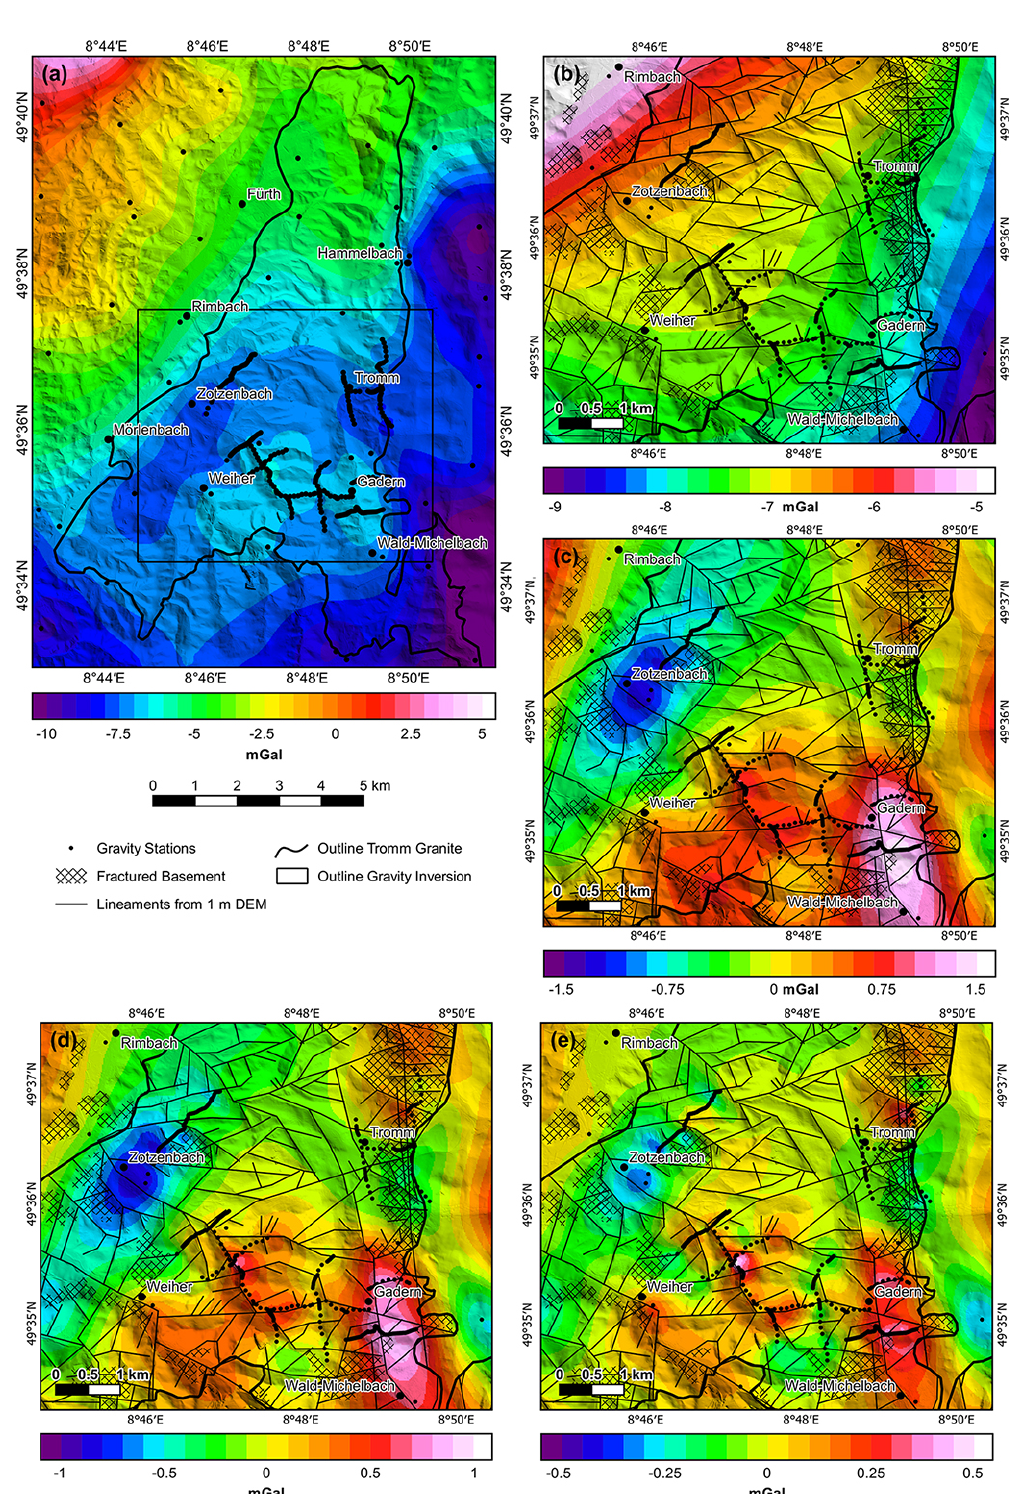
Figure 9. Results of the gravity survey: (a) complete Bouguer anomaly map for the Tromm Granite (© Leibniz-Institut für Angewandte Geophysik, © Hessische Verwaltung für Bodenmanagement und Geoinformation); (b) low-pass-filtered Bouguer anomaly with 10km cutoff wavelength; (c) high-pass-filtered Bouguer anomaly with 10km cutoff; (d) high-pass-filtered Bouguer anomaly with 5km cutoff; (e) high- pass-filtered Bouguer anomaly with 2km